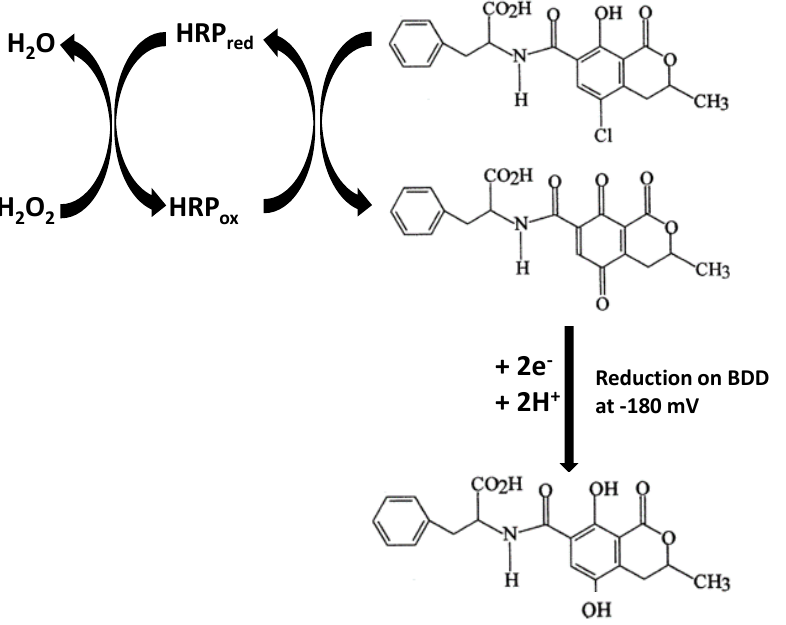
Figure 1. Mechanism of OTA oxidation by the oxidized HRP enzyme and of the origin amperometric signal.